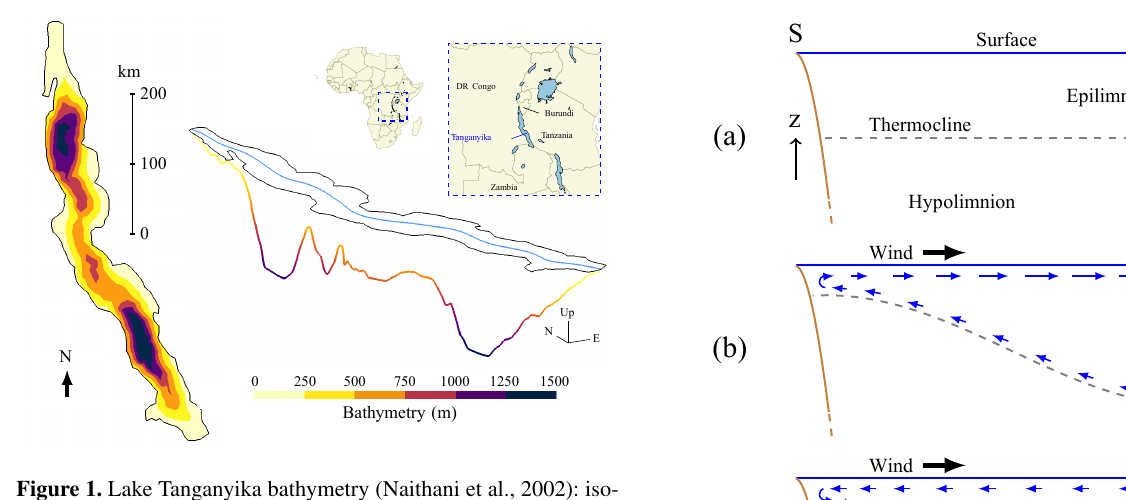
Figure 1. Lake Tanganyika bathymetry (Naithani et al., 2002): iso- baths (left) and perspective view of bottom profile along the main axis of the lake (right).